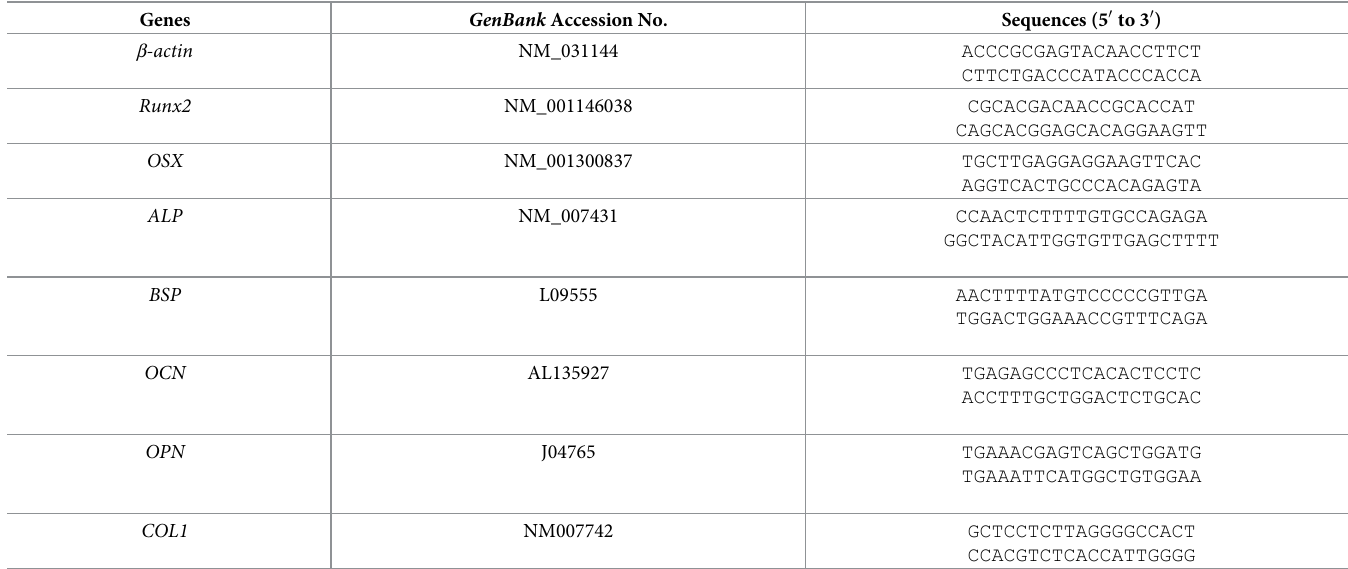
Table 1. Specified gene primer sequences used in qRT-PCR analysis. Genes